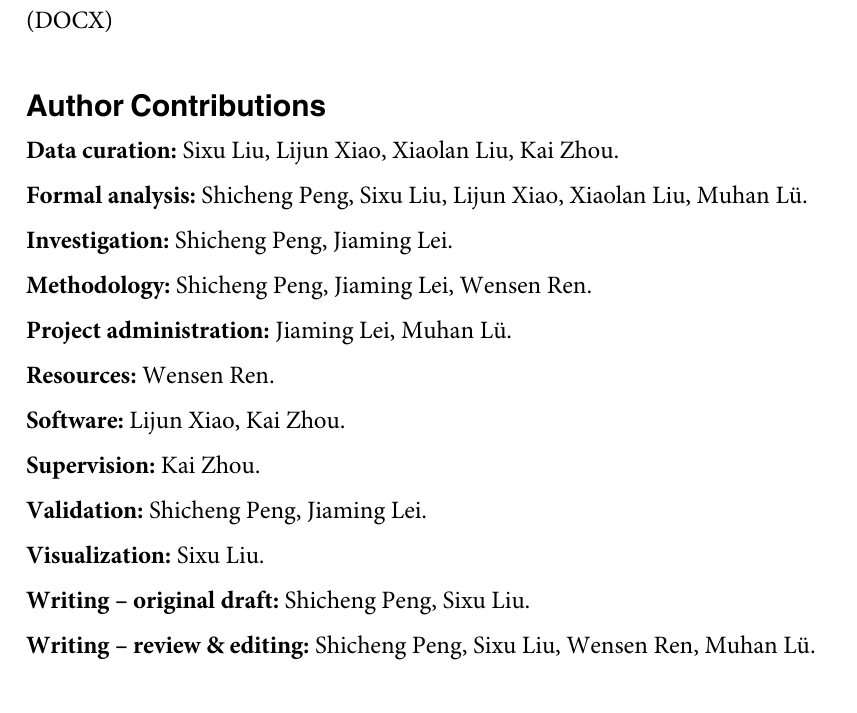
S8 Fig. Funnel plot comparing the effects of supplementary education based on traditional education and traditional education alone on the nonattendance rate. (TIF) S9 Fig. Forest plot comparing the effects of supplementary education combined with tradi- tional education versus traditional education alone on the nonattendance rate based on a fixed effect model. S1 File. PRISMA 2020 flow diagram for new systematic reviews which included searches of databases and registers